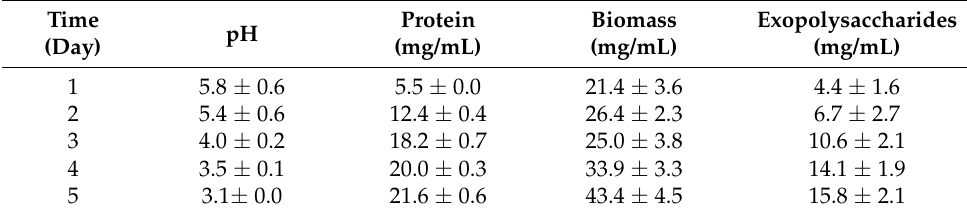
Table 1. Characterization of the A. malanogenum CK–CsC fermented